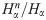
Concentration in neighbourhoods.For each class α we compute the fraction of households Hαn/Hα that belongs to an α neighbourhood. The figure shows the distribution of this fraction for all 2014 CBSAs.